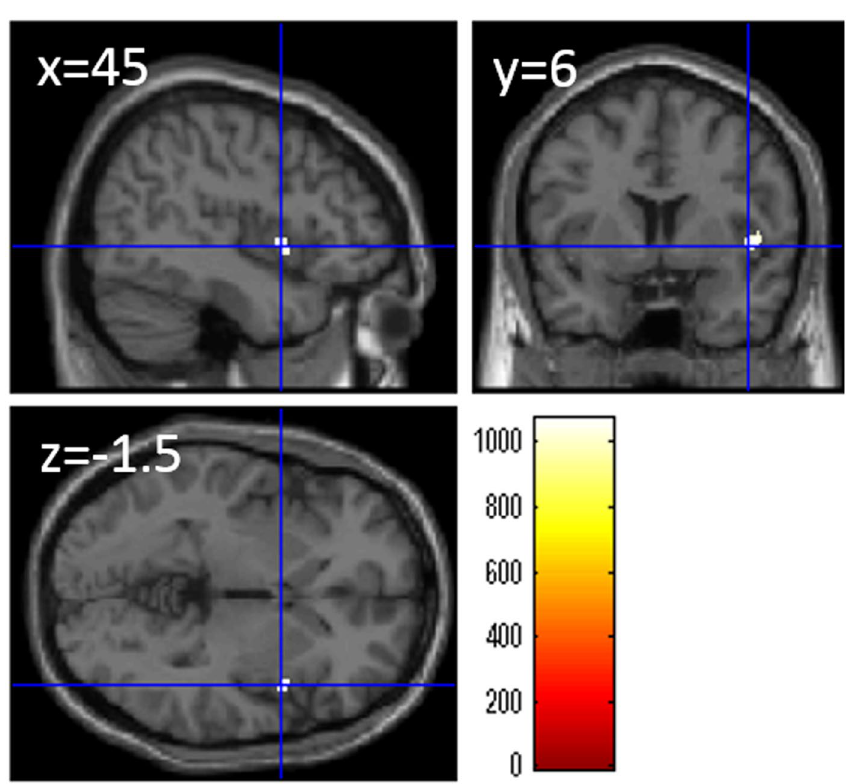
Figure 2. Relationships between verbal WM capacity (WMC) and rGMV after regressing out the effects of total gray matter volume. Panels show areas of significant positive correlation between the digit span score and rGMV by multiple regression analysis corrected for effects of age, sex, and total gray matter volume. The results shown were obtained using a threshold of TFCE, P < 0.05 corrected (FWE) based on 5000 permutations. The color bar represents the TFCE values in section images. Significant positive correlations were found in the right